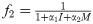
Comparison of solutions for system (1) with and without media effect.Black, red, blue curves represent the result of without media effect (f0 = 1), with media function f1 = e−α1I−α2M, and with media function f2=11+α1I+α2M, respectively.